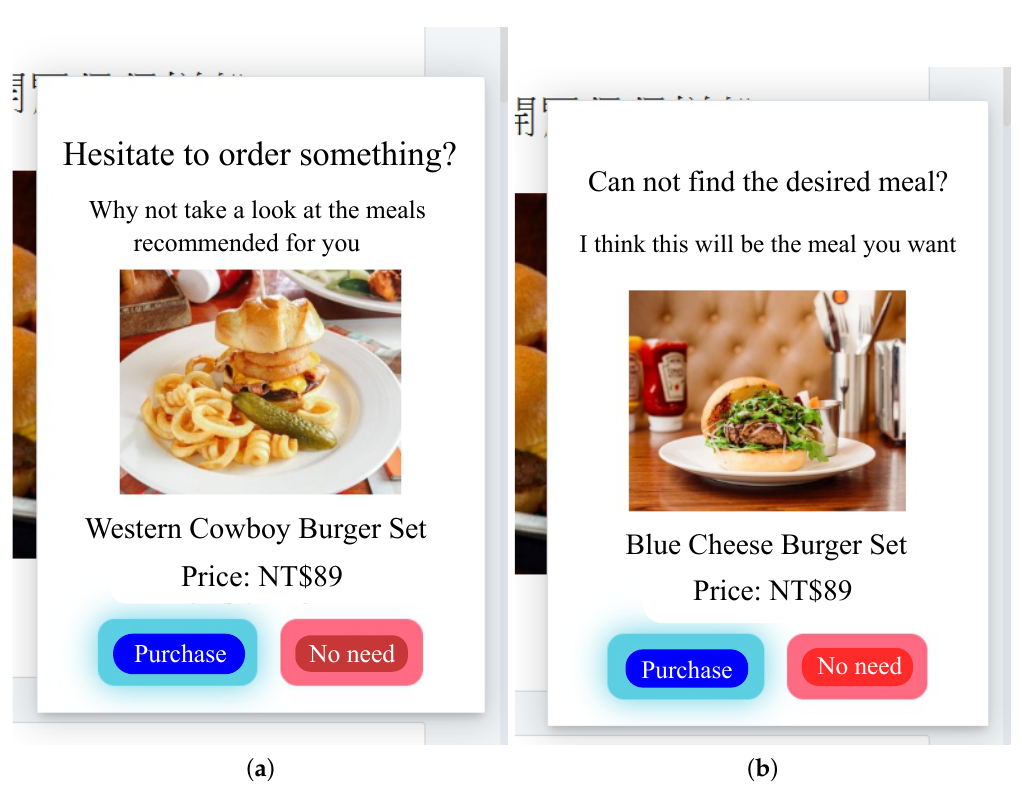
Figure 14. Different types of notifications on the AI-QSR UI. ( a ) The UI of the idle-triggered recom- mendation. ( b ) The UI of the browsing-triggered